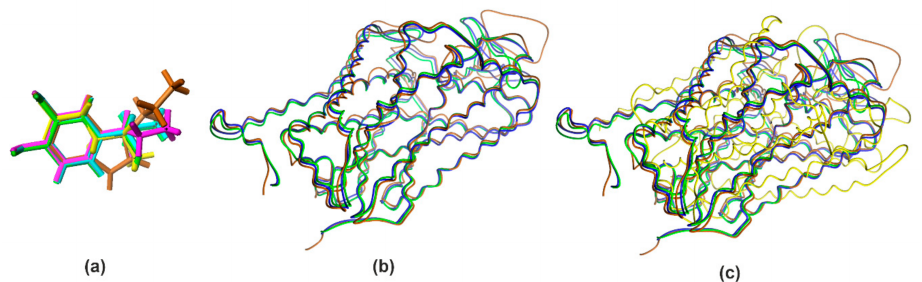
Figure 1. Superimposition of the investigated docked structures of neurotransmitters: serotonin (SER, brown), dopamine (DA; blue), noradrenaline (NE, green), γ -aminobutyric acid (GABA, yellow) ( a ), and human monoamine transporters: serotonin transporter (hSERT, brown), dopamine trans- porter (hDAT, blue), norepinephrine transporter (hNET, green) ( b ), human transporters: serotonin transporter (hSERT, brown), dopamine transporter (hDAT, blue), norepinephrine transporter (hNET, green), and γ -Aminobutyric acid transporters 1 (hGAT1, yellow) ( c